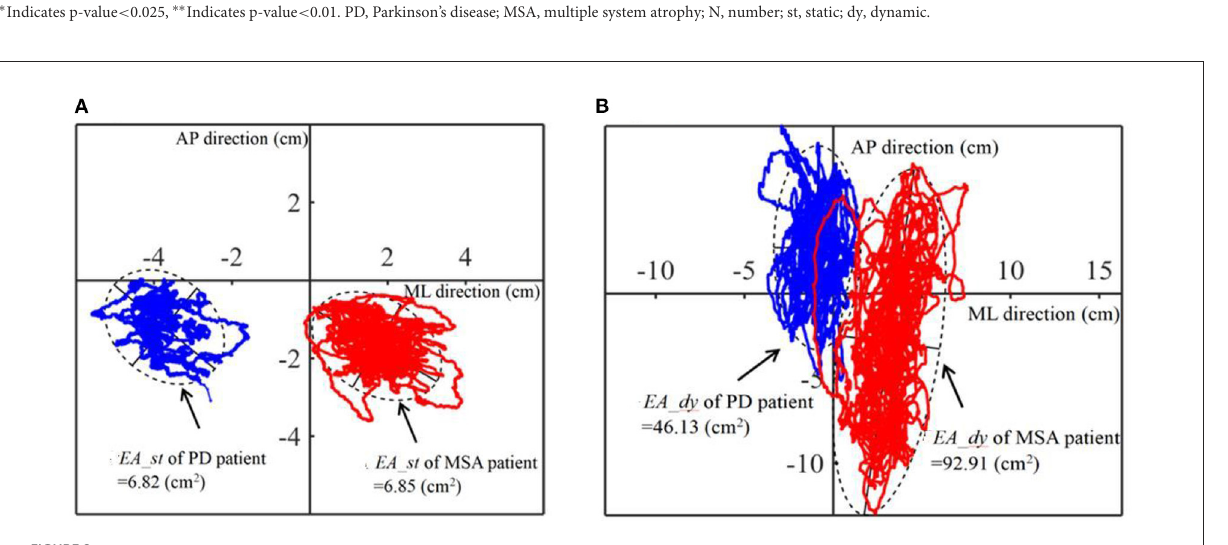
FIGURE2 Schematic diagram of parameter EA of one PD patient and one MSA patient. (A) Static balance experiment. (B) Dynamic balance experiment. PD, Parkinson’s disease; MSA, multiple system atrophy; COP, the center of pressure; ML, medial-lateral; AP,